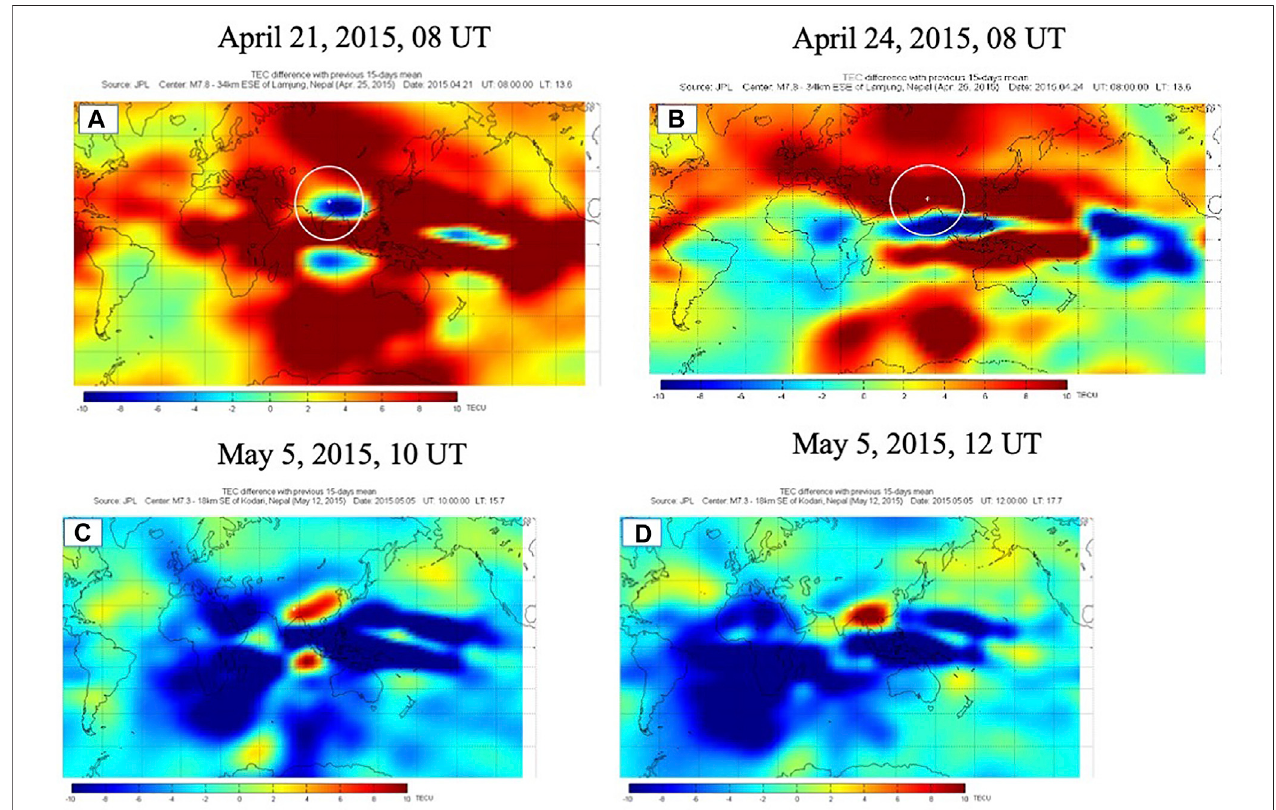
FIGURE8| GIMGPSffECspatialanalysis. (A) DifferentialTECmapofApril21,2015,( − 4 days)09UTand (B) April24,2015,08UT( − 1 day) (C) DifferentialTECmap of May 5, 2015, ( − 7 days) !OUT and (D) May 5, 2015, 12UT ( − 7 day).